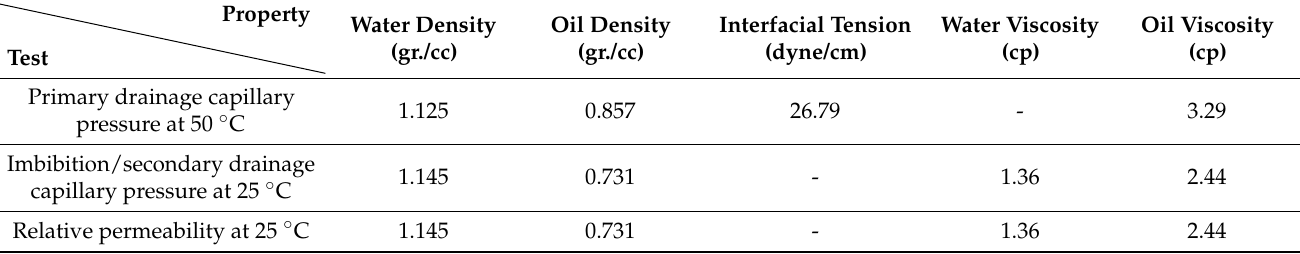
Table 2. Fluid characteristics used in the primary drainage and imbibition/secondary drainage experiments.